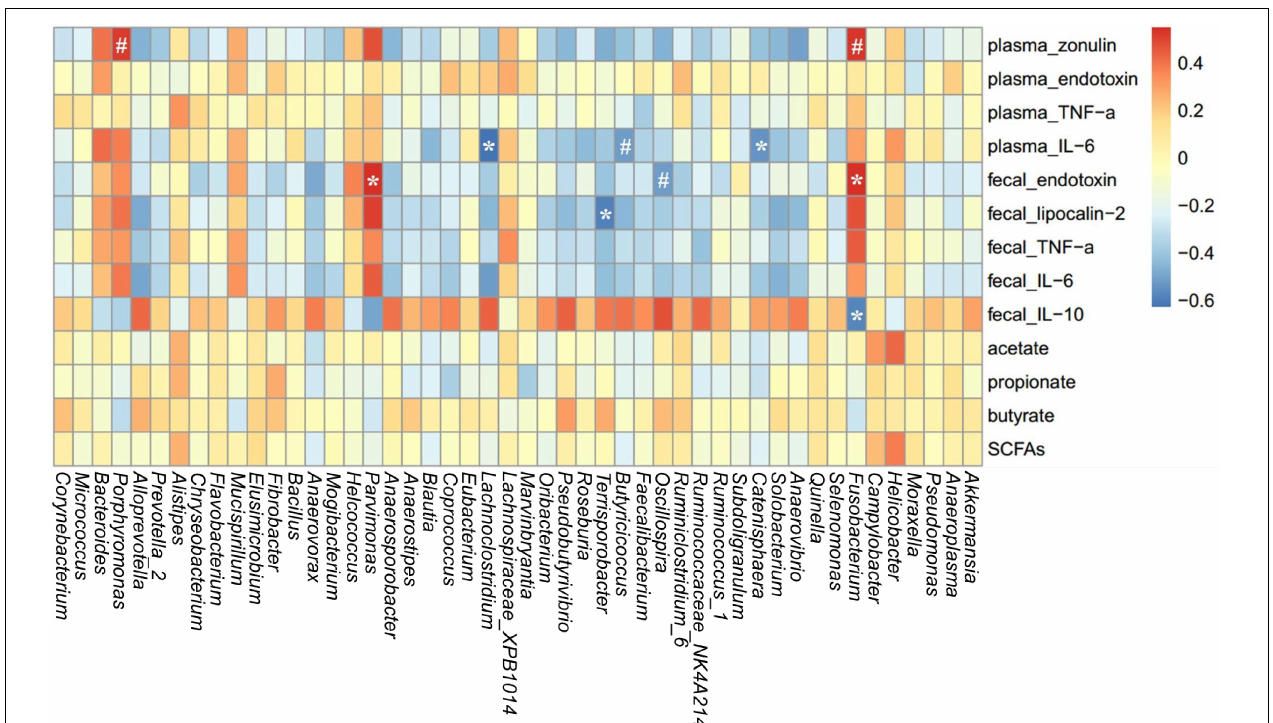
FIGURE 8 | Heatmap of the spearman r correlations between the gut microbiota significantly modified by different reproductive stages and metabolic parameters of sows. Data are presented as means ± SEM ( n = 12). ∗ P < 0.05; # P < 0.1 (following the Spearman correlation analysis). SCFAs is the sum of acetate, propionate, and